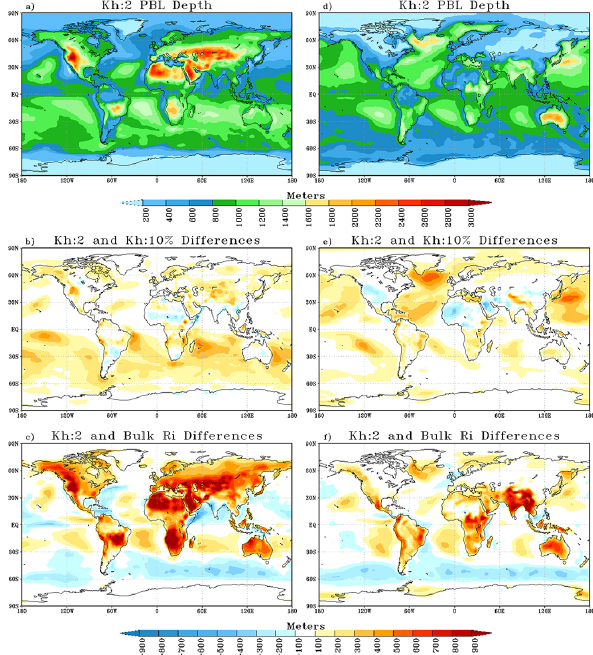
much as 1 km or more. Consistent with McGrath-Spangler